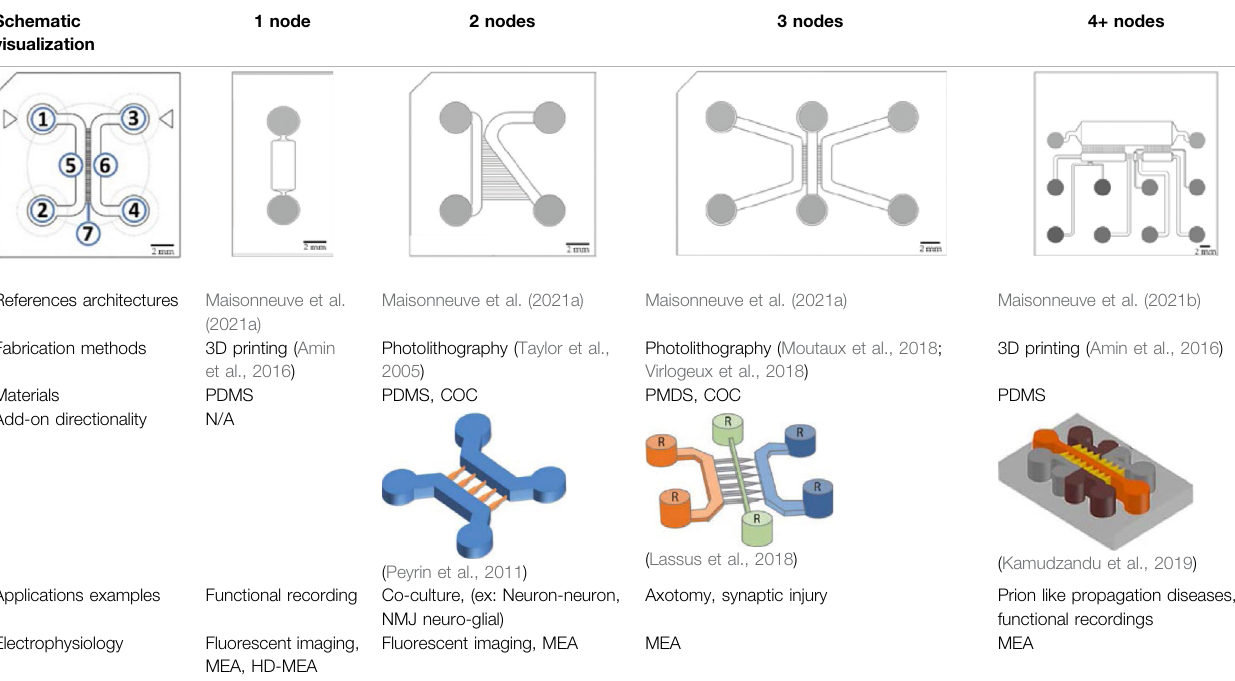
TABLE 1| Characteristics and reported applicationsofdifferentmicro fl uidicdevicesused in neuroscience research (Kamudzanduet al., 2019).Adapted from Kamudzandu et al. (2019) (copyright Biomedical Physics & Engineering Express) (Peyrin et al., 2011); Extracted and adapted and from Peyrin et al. (2011). (copyright Lab on a Chip) (Lassus et al., 2018); Extracted and adapted from Lassus et al. (2018) (copyright Scienti fi c Reports). Schematic visualization: 1 and 3: inlets; 2 and 4: outlets; 5 and 6: channels; 7: microchannels/microgrooves. Schematic